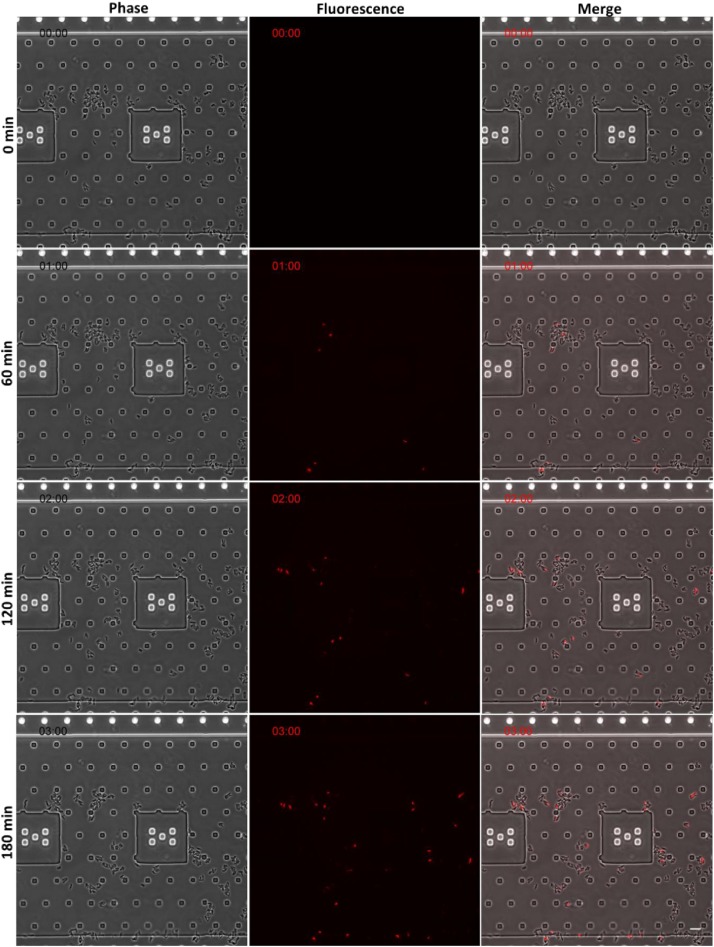
Time-lapse fluorescence microscopy images of BCG (for safety reasons) following 3 h treatment with peptoid BM 2 at 4 × MIC (32 mg/L) in the presence of the membrane-impermeable dye, propidium iodide (PI). Peptoid-mediated membrane disruption promoted uptake of PI into bacterial cells. Images are presented from one representative experiment. Scale bar = 10 μm.